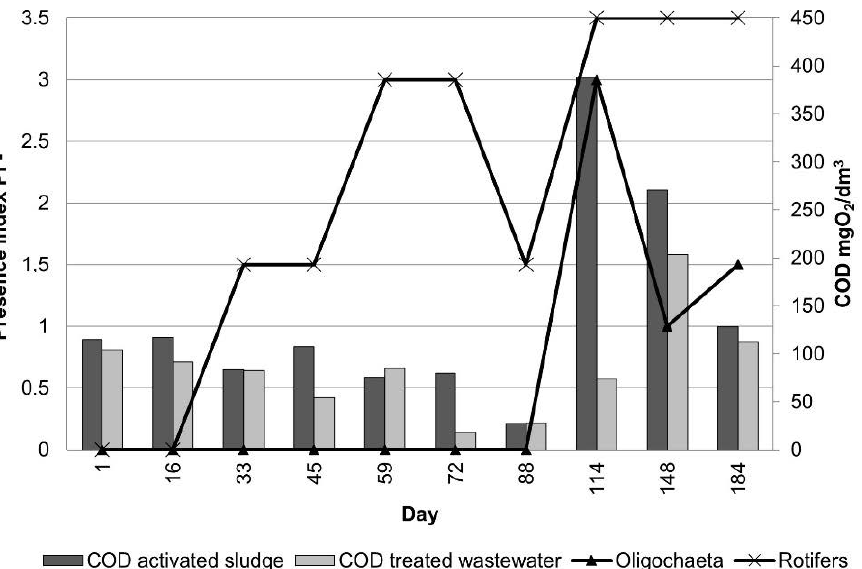
Figure 13. Changes in COD concentrations in treated wastewater from the 1st to the 184th day of operation (April–October 2021) with the Oligochaeta and rotifers presence index.